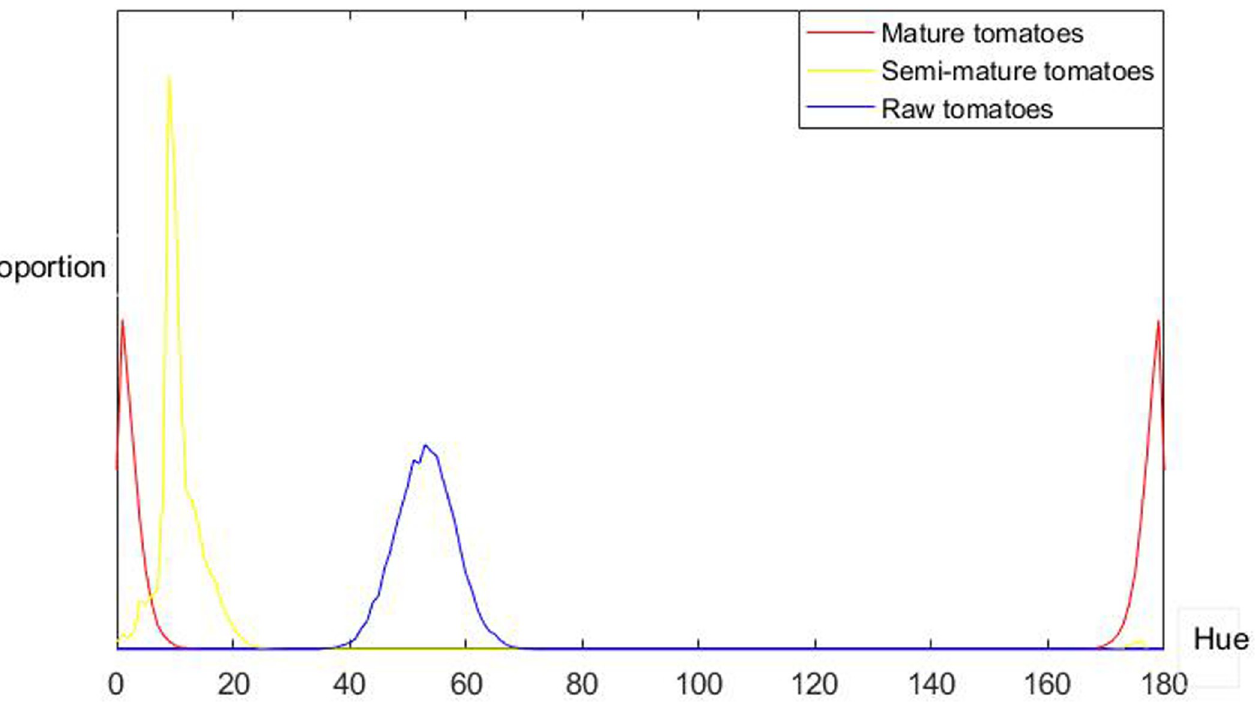
PLOS ONE | https://doi.org/10.1371/journal.pone.0219803 July 18,